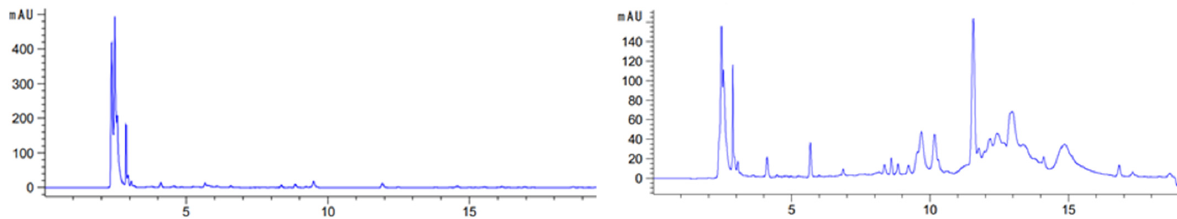
Figure 5. Polyphenolic profiles of Frankfurter sausage meat product ( left ) and Frankfurter sausage vegetarian product ( right ).